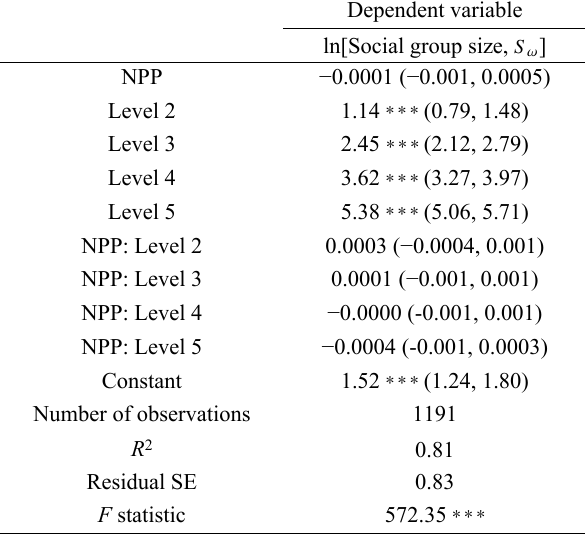
Table 5 Hunter-gatherer social group size across levels by net primary productivity NPP.